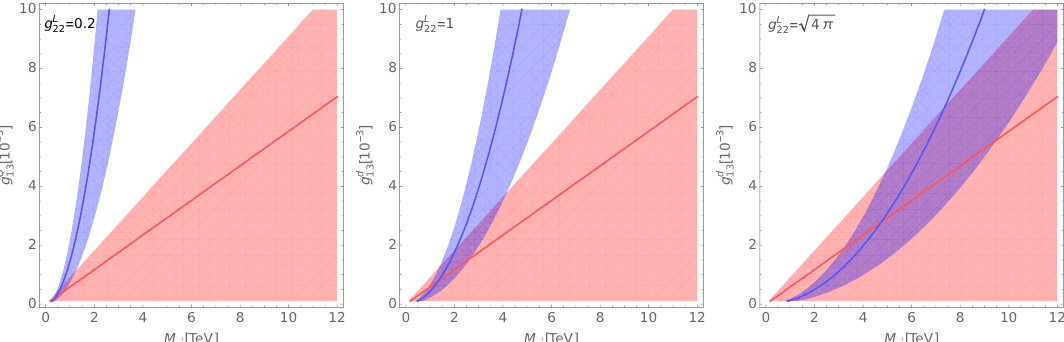
Figure 3 . Bounds from B 0 (cid:0) (cid:22) B 0 mixing on the coupling g Q p g L = 1 (middle) and g L = 4 (cid:25) (right). The red area corresponds to preferred 1 (cid:27) region from 22 22 (cid:1) M d and the blue one to 1 (cid:27) region from B (cid:6) ! (cid:25) (cid:6) (cid:22) + (cid:22) (cid:0)